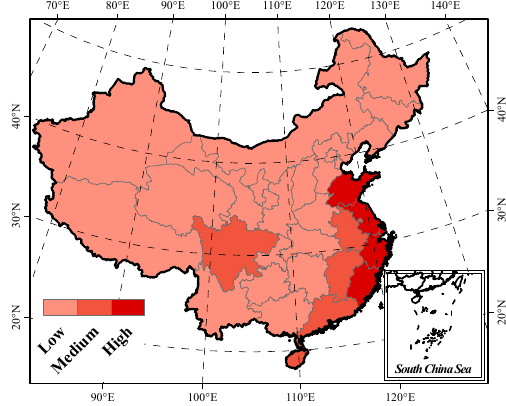
Figure 10. Rates of urban expansion from the 1990s through to the 2010s in China (modified from Wang et al.,